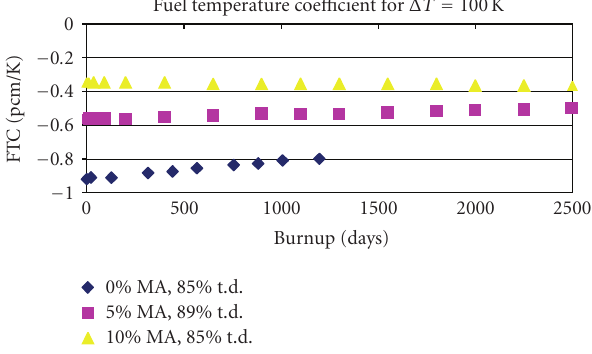
Figure 5: The fuel temperature coe ffi cient as a function of MA- fraction in the fuel.